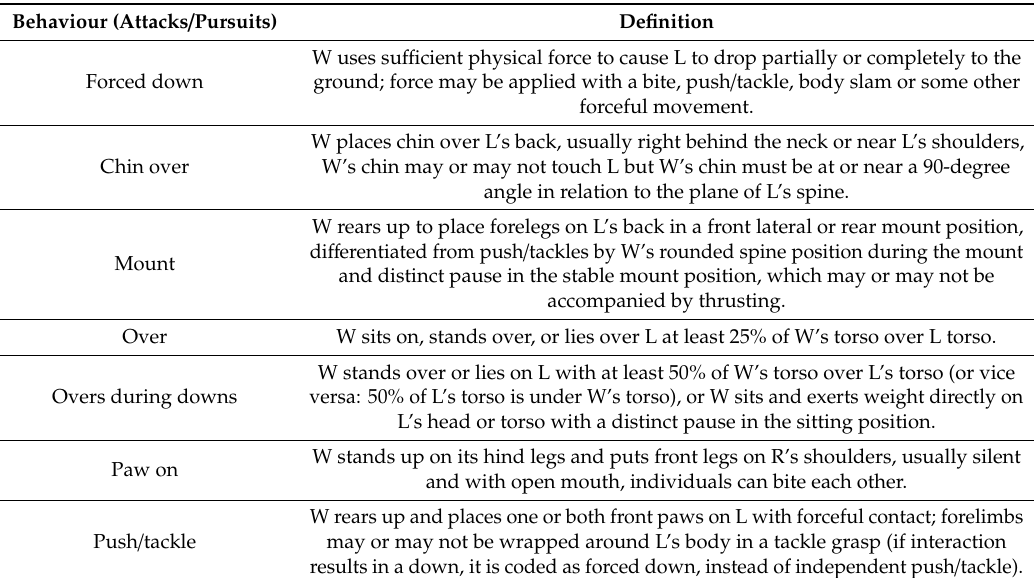
Table 2. Ethogram of behaviours displayed in the play context in domestic dogs ( Canis familiaris ) adapted from previous study [35]. W—winner,